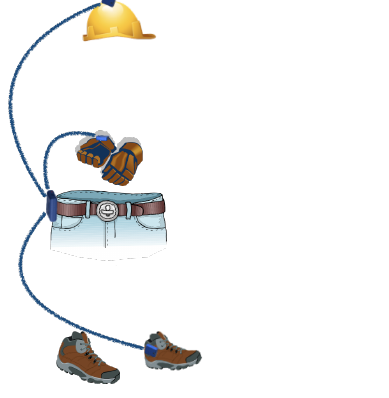
Figure 6. A personal area network.